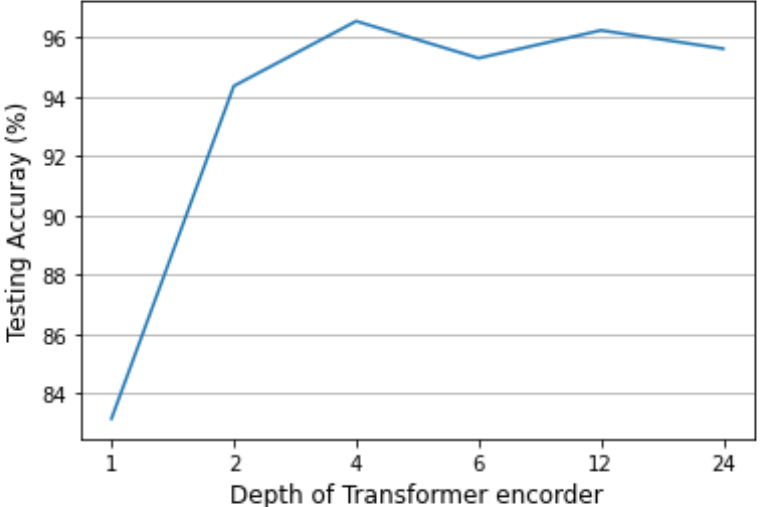
Figure 6. The influence of the depth of the Transformer encoder.